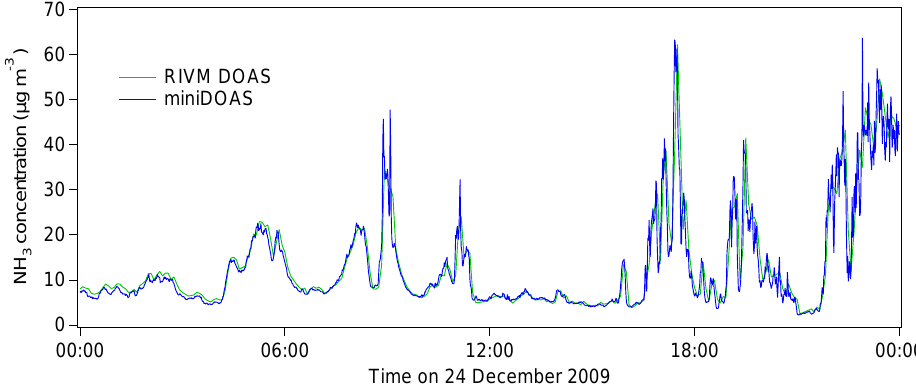
Fig. 15. A further zoom in on RIVM DOAS (5-min values) and miniDOAS data (1-min values) obtained in the field in Vredepeel on 24 December 2009.